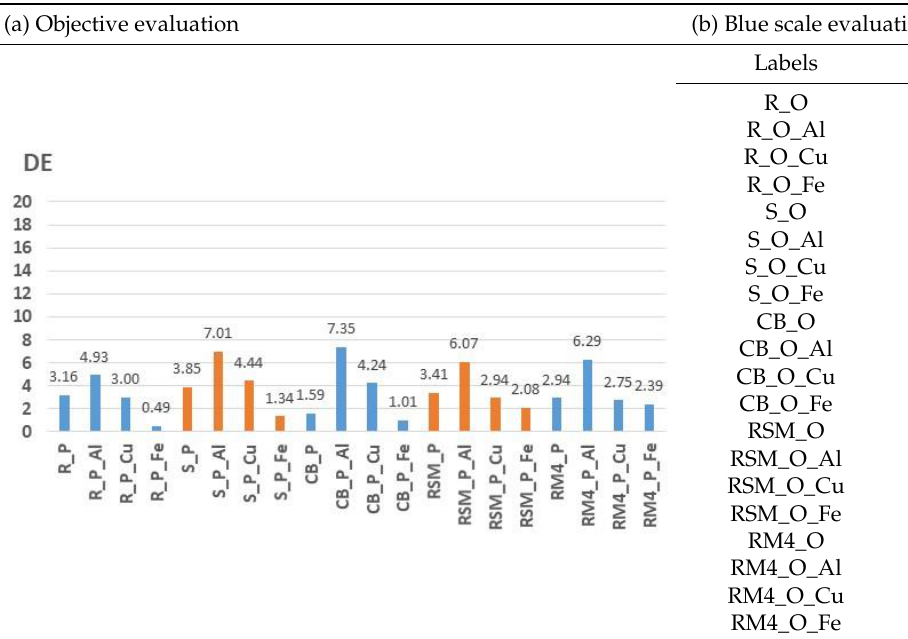
Table 10. Light fastness of cotton yarns dyed with onion peel.